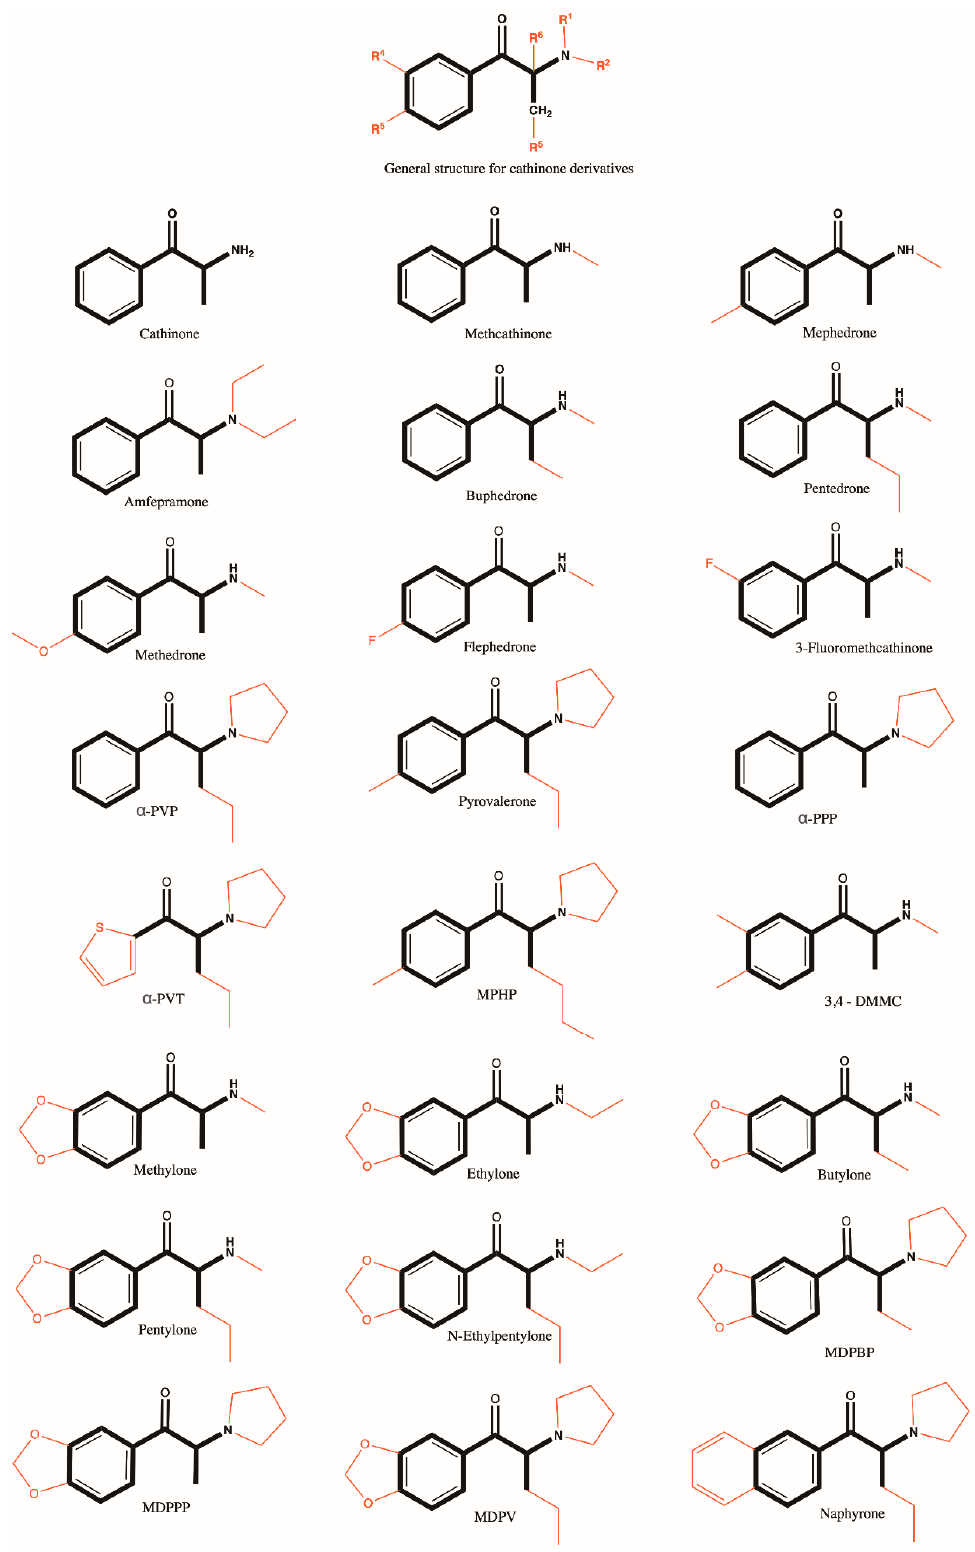
Figure 1. Chemical structure of cathinone derivatives .